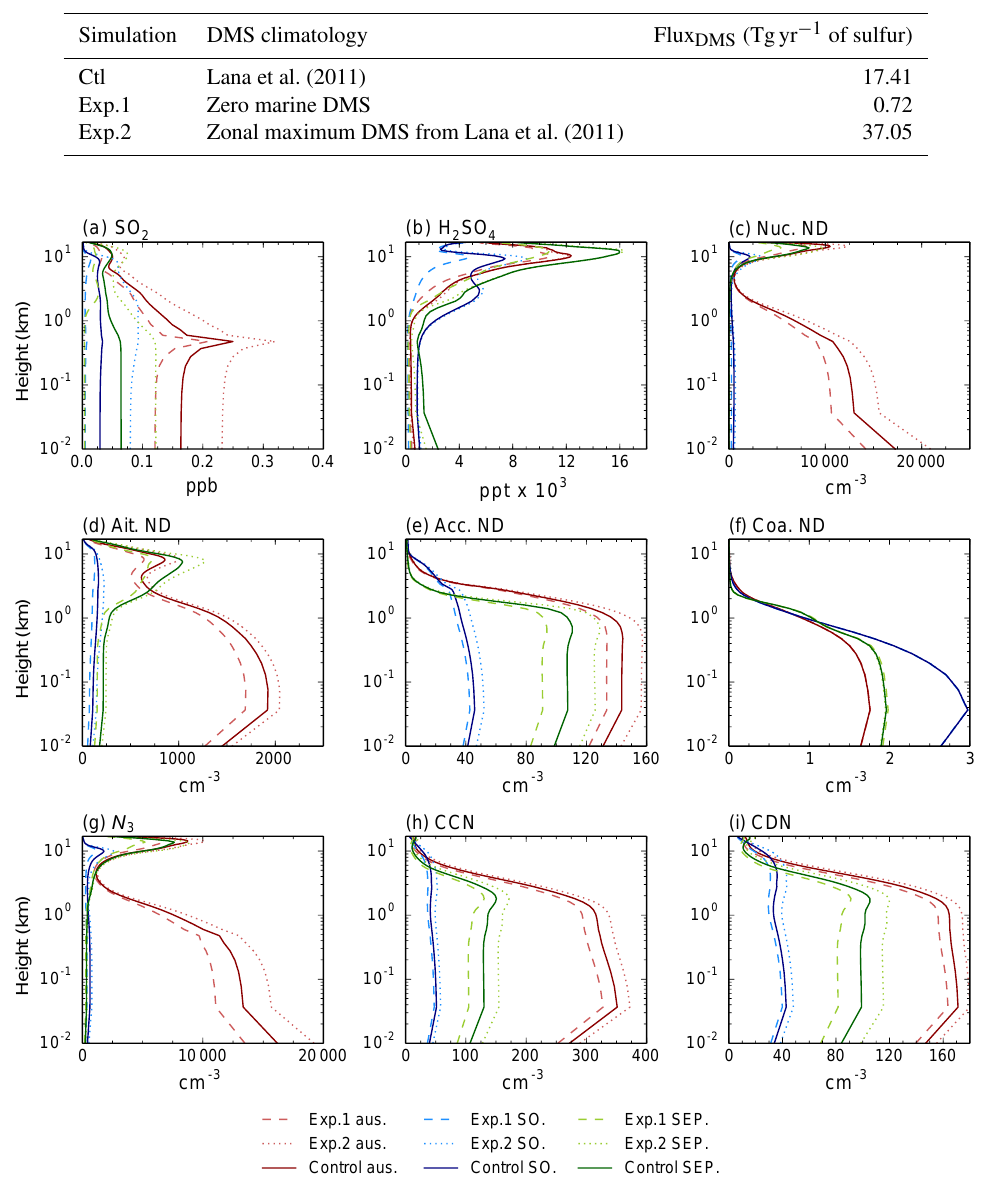
Figure 7. The vertical profiles of (a) SO 2 , (b) H 2 SO 4 , (c) nucleation-mode number density, (d) Aitken-mode number density, (e) accumulation-mode number density, (f) coarse-mode number density, (g) N 3 nuclei number, (h) cloud condensation nuclei number and (i) cloud droplet number. The solid lines represent the Ctl, dashed lines shows Exp.1 and dotted lines show Exp.2. Blue lines show the SO (SO) mean, red the Australian (Aus) region mean and green the south-eastern Pacific (SEP). All units are cm − 3 , apart from (a) ppb and (b) ppt × 10 − 3 .